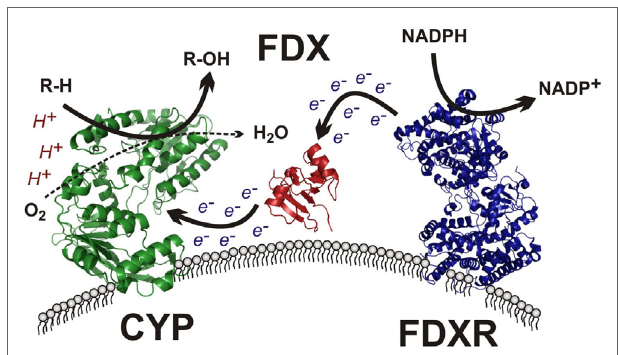
FiGURe 4 | Mitochondrial cytochrome P450 electron transport chain . The membrane-bound flavin-containing ferredoxin reductase (FDXR) accepts two electrons from NADPH, yielding NADP + . These electrons are passed to the iron–sulfur cluster of ferredoxin (FDX), which donates the electrons to the heme prosthetic group of the mitochondrial cytochrome P450 (CYP), which uses protons and molecular oxygen to hydroxylate its target substrate (R–H) yielding the final hydroxylated product (R–OH) and